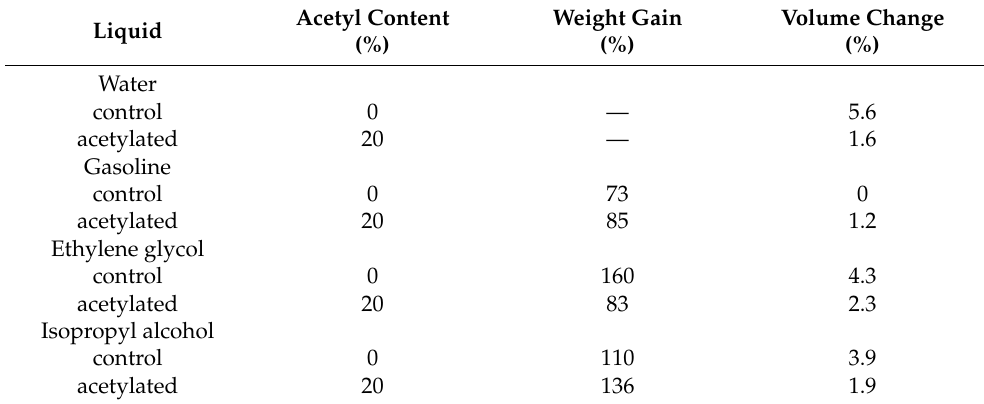
Table 3. Swelling of control and acetylated balsa in water and various organic fluids [7]. Acetyl Liquid